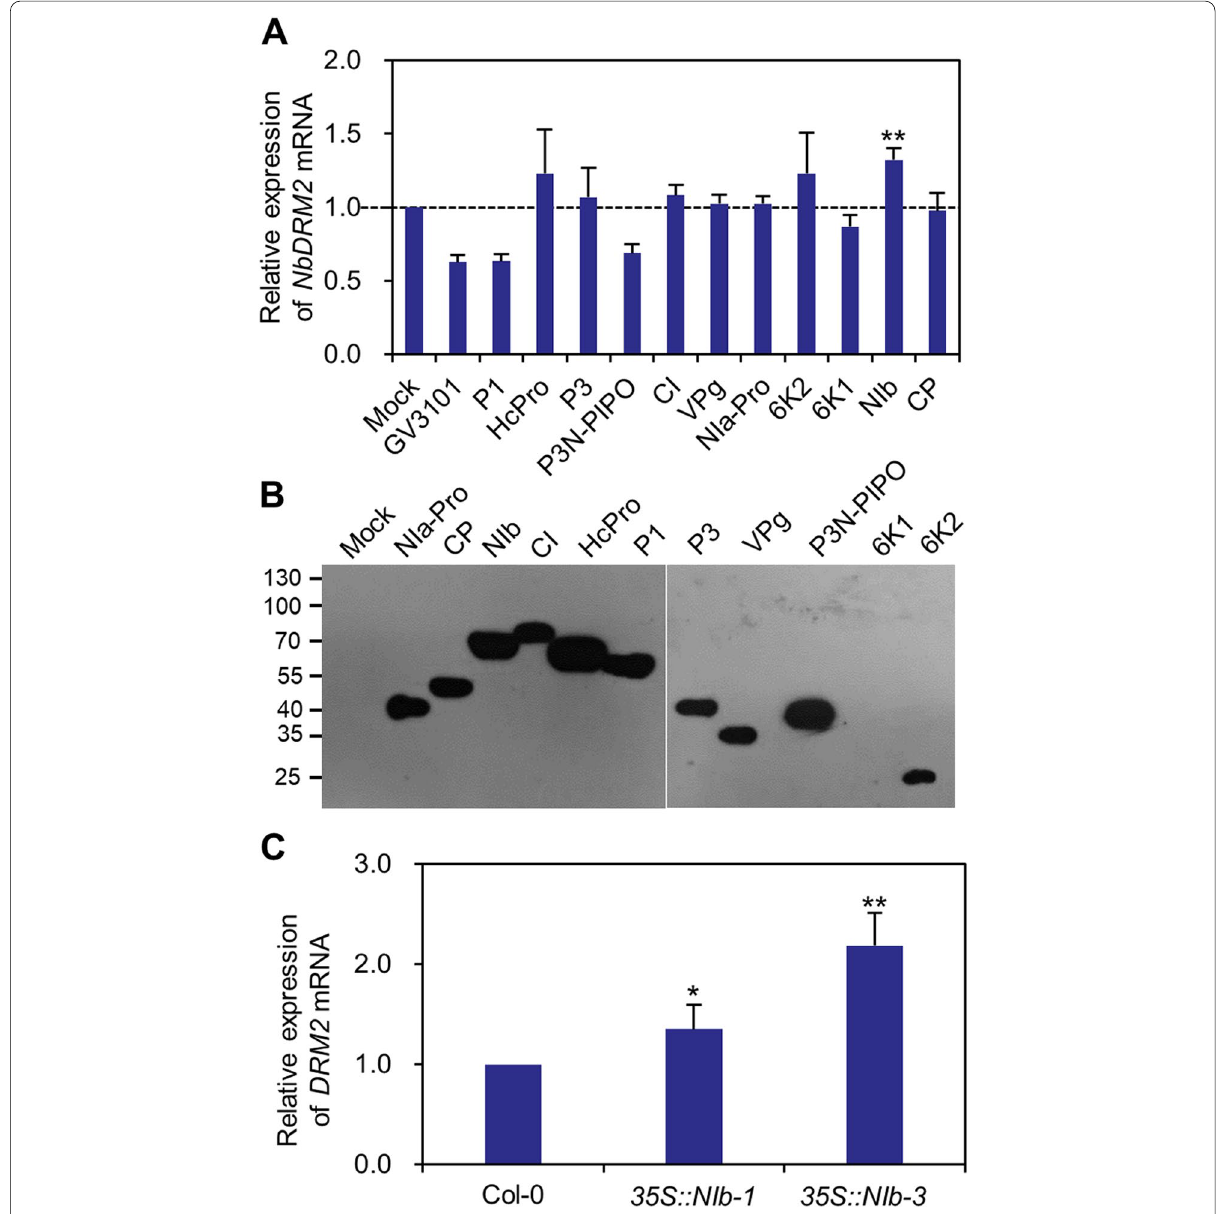
Fig. 5 TuMV-encoded NIb induces the expression of DRM2 . A RT-qPCR analysis the expression of NbDRM2 in N. benthamiana epidermal leaves infiltrated with buffer (mock), empty Agrobacterium strain GV3101, or one of the eleven TuMV-encoded proteins. B Validation the expression of the eleven TuMV-encoded proteins by Western blot with anti-Myc antibodies. C RT-qPCR analysis the expression of DRM2 in wild-type or two transgenic lines expressing FLAG-4 Myc-tagged NIb under the cauliflower mosaic virus 35S promoter ( 35S:NIb-1 and 35S:NIb-3 ). ACTIN II was used as the × internal control. Transcript level in wild-type plants was normalized to 1. * and ** indicate p < 0.01 and 0.001 of the student t -test, respectively. Data are mean s.d. ( n ± =